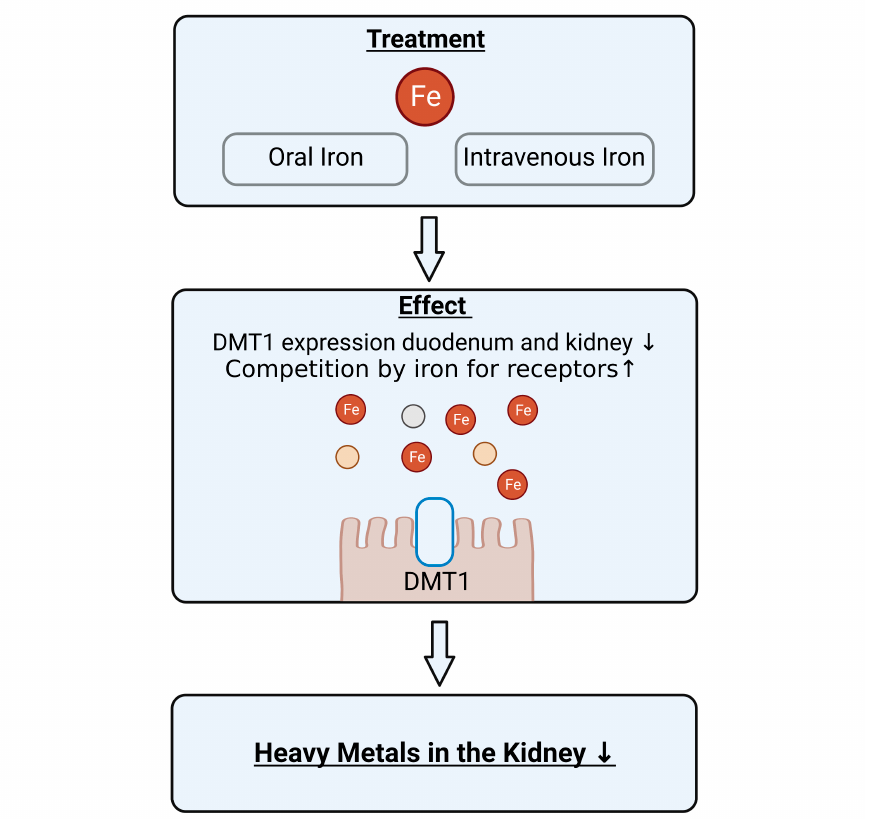
Figure 4. Hypothesized effect of correcting iron deficiency. DMT1: divalent metal transporter 1.